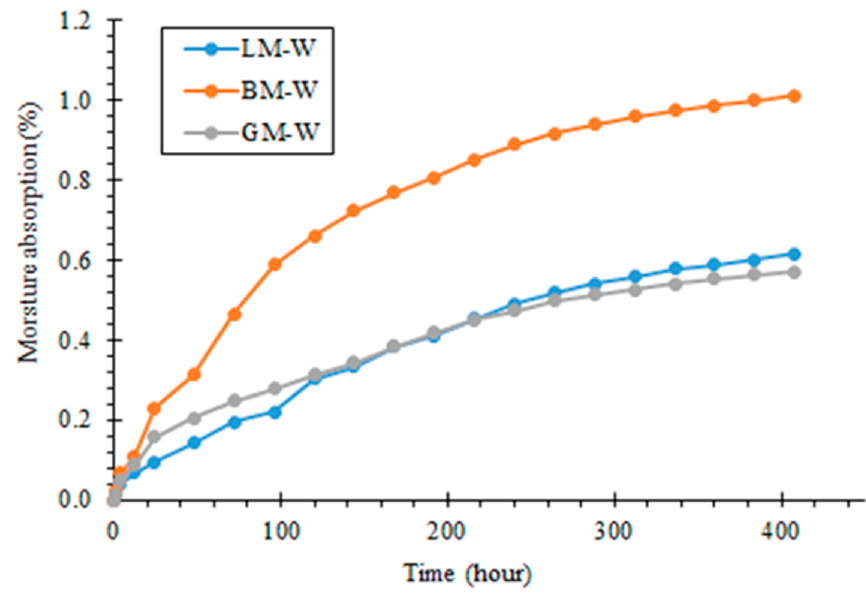
Figure 9. Moisture absorption curves of asphalt mastics.